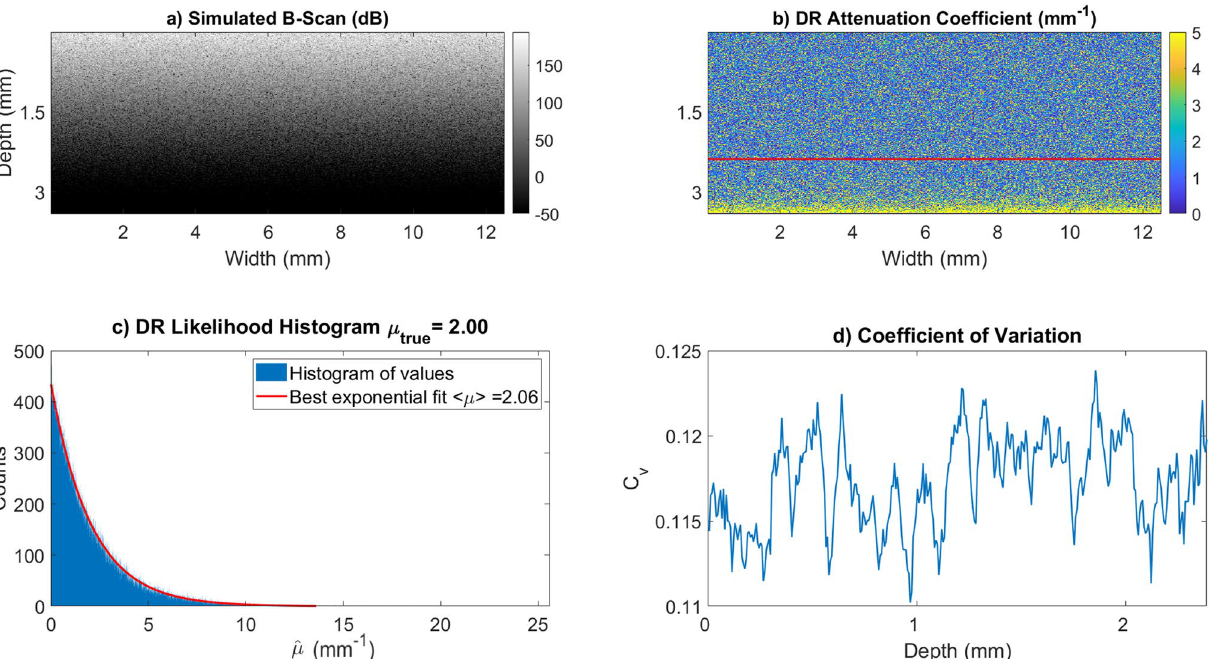
Figure 4. This figure demonstrates the accuracy of the likelihood model and estimates the coefficient of variation of the signal to verify the assumptions made in (14) for simulated signals. Both the simulations and figure creation were done in Matlab 2019a 27 , https ://www.mathw orks.com/. ( a ) This panel is a simulated B-Scan, 1 1 10 7 , µ oct 2.00 mm 0.3 , I inc which was simulated using parameters β NA , lateral resolution of − = × = = 0.022 mm and (cid:31) z 0.0068 mm in a domain which is 3.4 mm deep. ( b ) This is the DR reconstructed (cid:31) x = = much higher than the true value. The estimates below the red line are truncated to avoid the exponential grown artifact. ( c ) This figure is a histogram of the top 70% of pixels from ( b ). As shown in Eq. (17) we expect this to these simulations, C v stays near 0.12 at all admissible